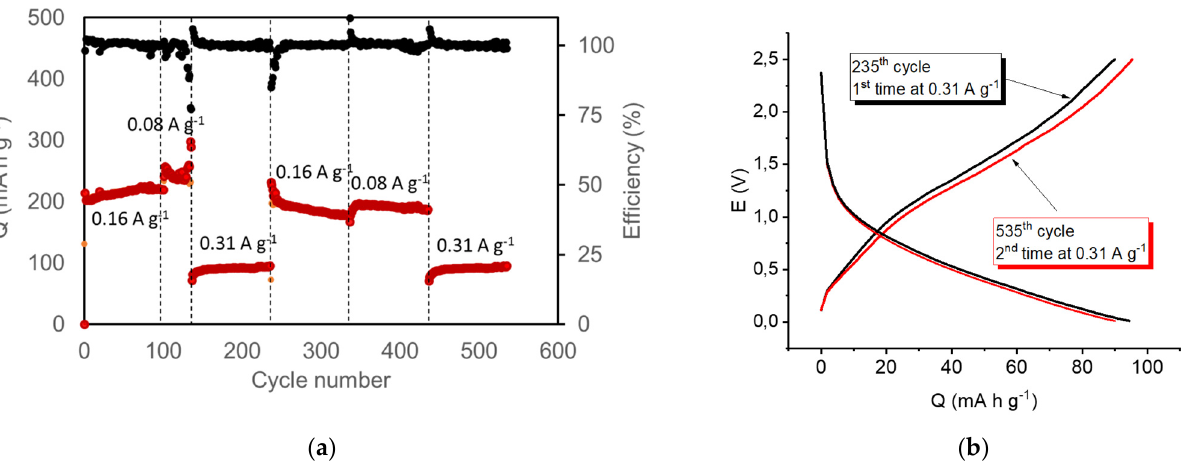
Figure 6. Long-term cycling for Ce-CMK3 anode: ( a ) Q vs. cycle number at different current rates and ( b ) selected E vs. Q curves at 0.31 A g − 1 .